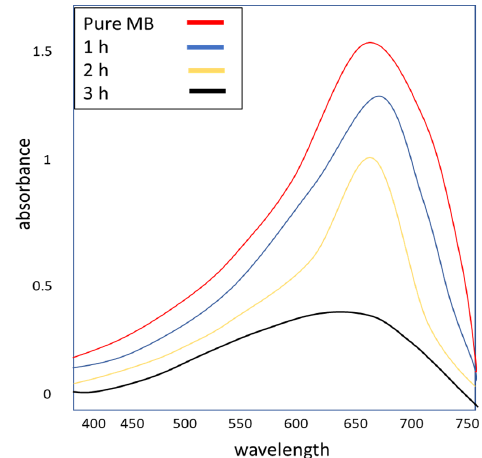
Figure 9. Photodegradation of the MB dye in the presence of the synthesized SNPs.